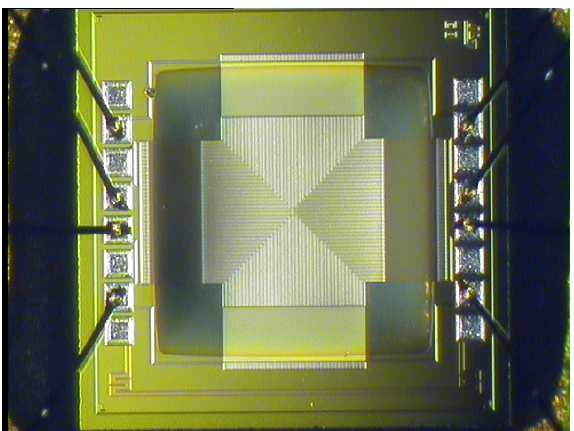
Figure 1. Microphotograph of the proposed micromachined thermopile sensor.